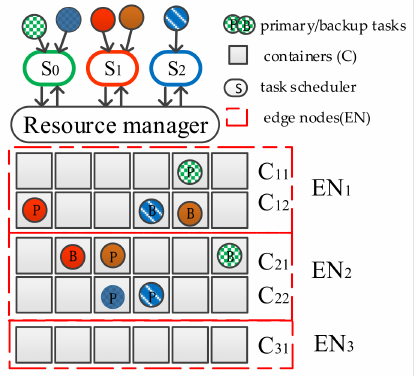
Figure 1. Problem analysis in the process of task copy